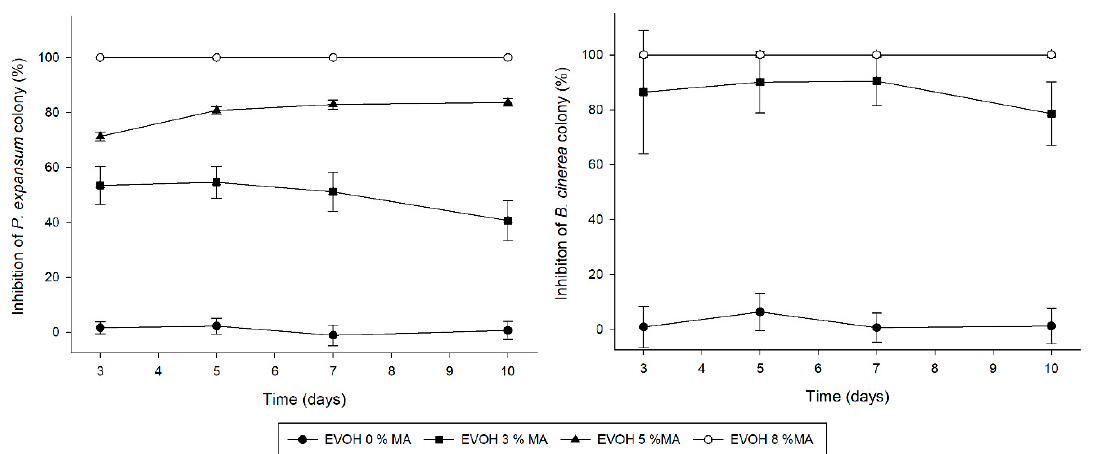
Figure 8. Effectiveness of EVOH incorporated with methyl anthranilate against P. expansum and B. cinerea expressed as inhibition of fungal colony (%) during 10 days of at 26 °C.